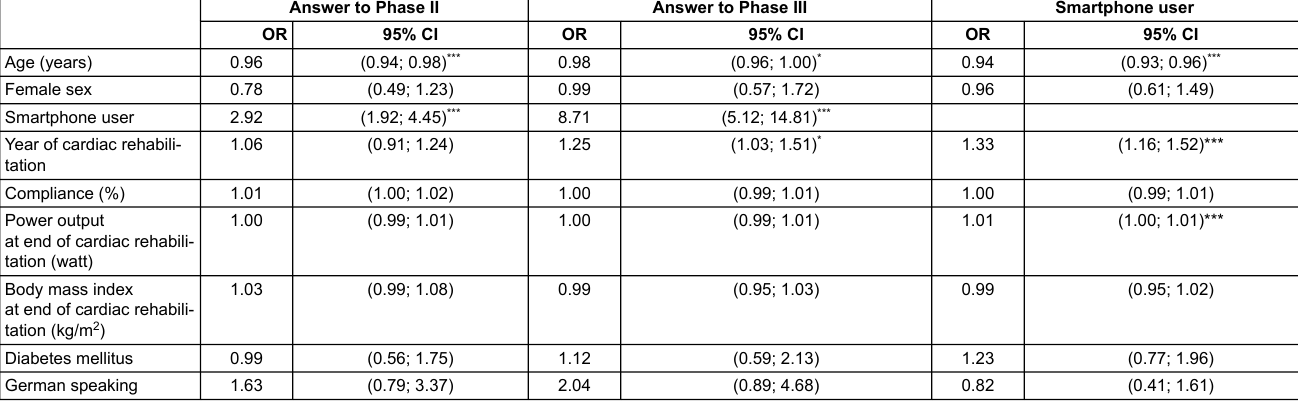
Table 4: Multivariate logistic models for answering questions to phase II and III and for smartphone